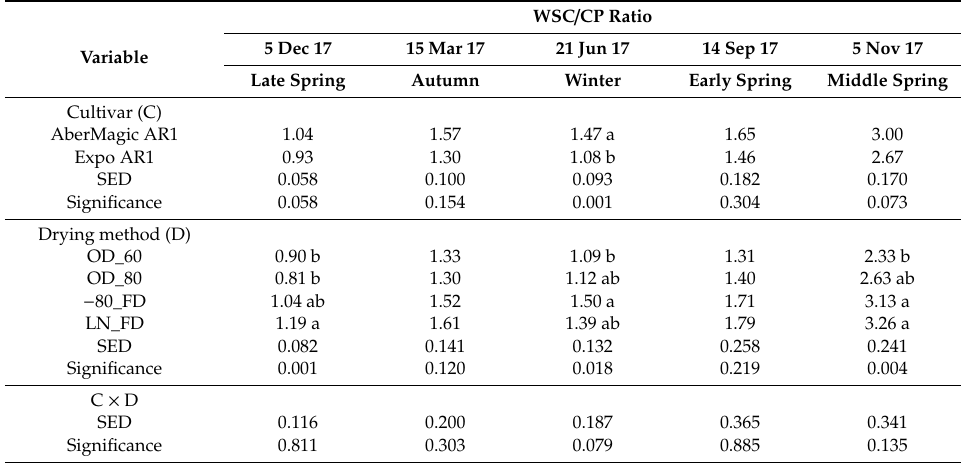
Table 3. Water-soluble carbohydrate (WSC) to crude protein (CP) ratio in AberMagic AR1 and Expo AR1 cultivars dried under di ff erent procedures in five